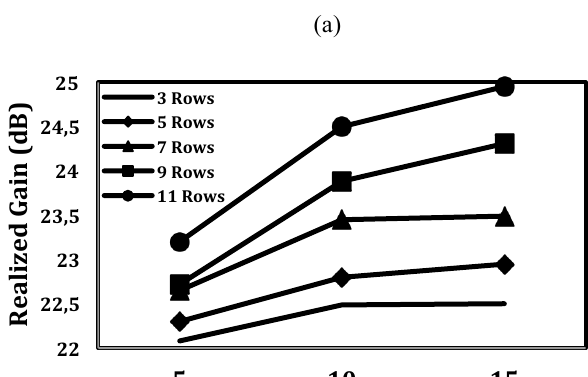
Figure 2: Pyramidal horn antenna and 3D meta surface lens and Unit cell with SRR